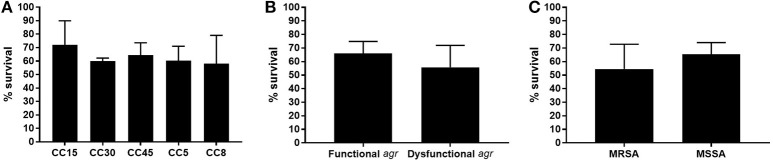
Susceptibility to hNP-1. Susceptibility to hNP-1 of the different CCs (A), according to agr functionality (B), and methicillin resistance (C). The bars and error bars indicate the means and standard deviations for each group, respectively (at least three independent assays per strain). There are no statistically significant differences.